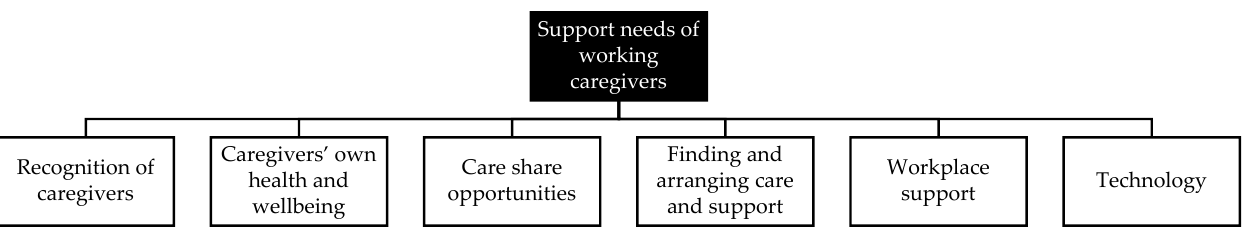
Figure 1. An overview of themes related to working caregivers’